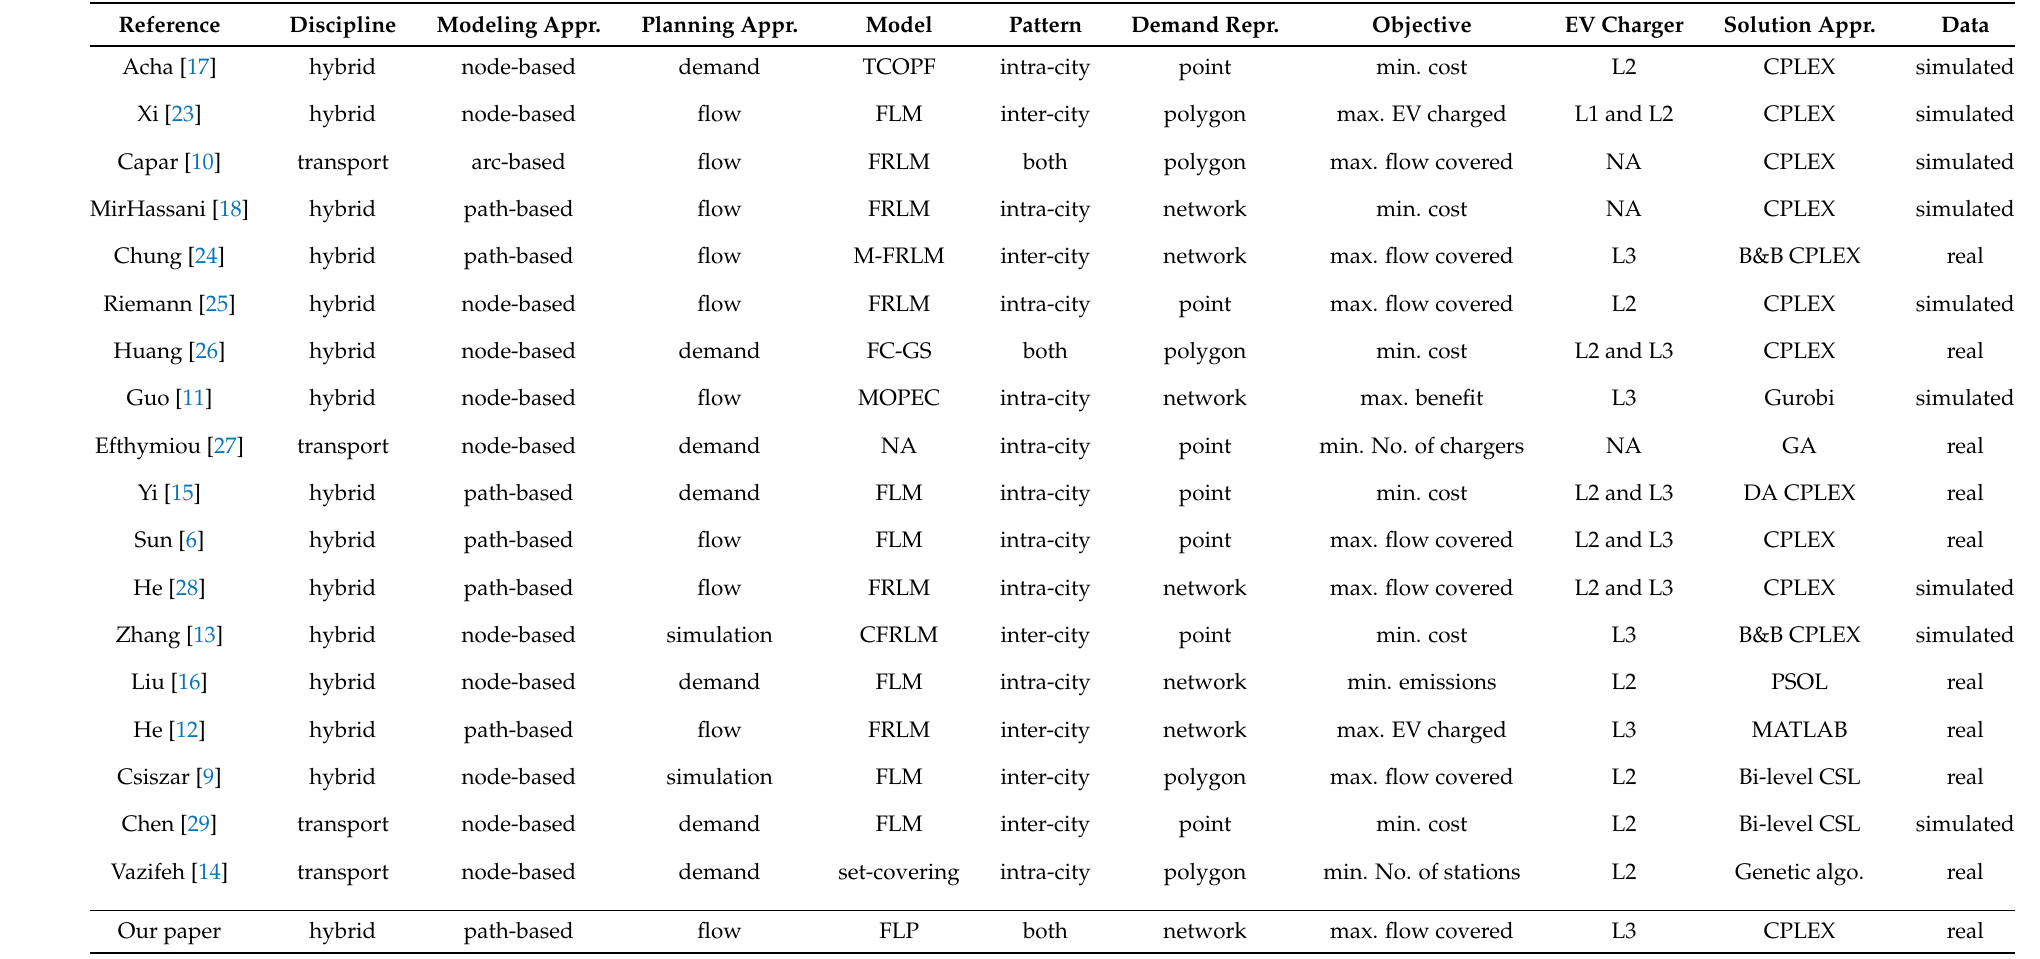
Table 2. Literature